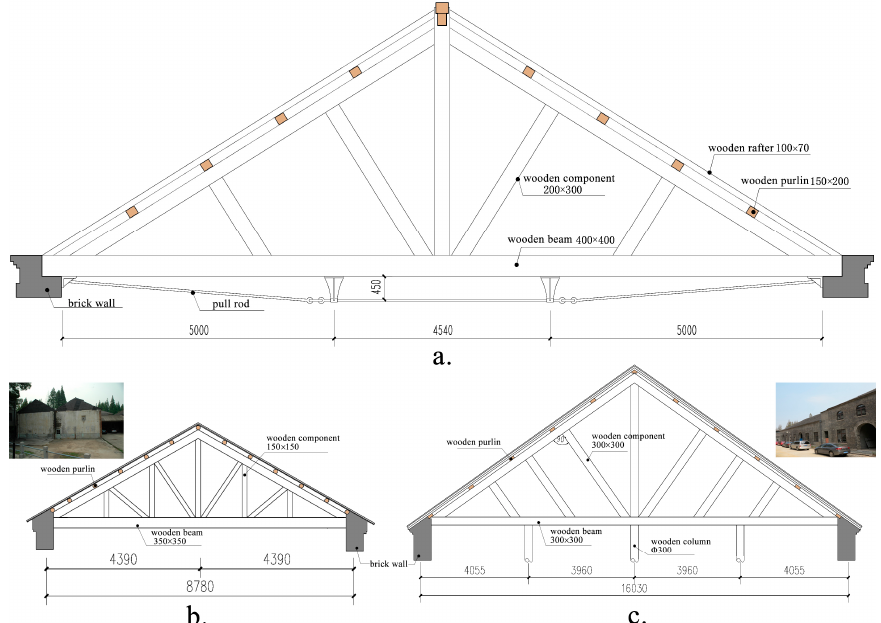
Figure 10. The roof truss of LMF (( a ) 1887); the other two buildings in Jinling Machinery Bureau (( b ) 1882; ( c ) 1886). Pictures by